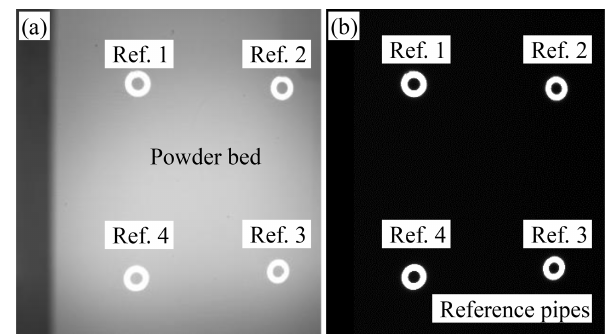
Figure 5. Original image of powder bed plane with illuminated ref- erencing pipes, (a) under process conditions and (b) without exter- nal illumination.